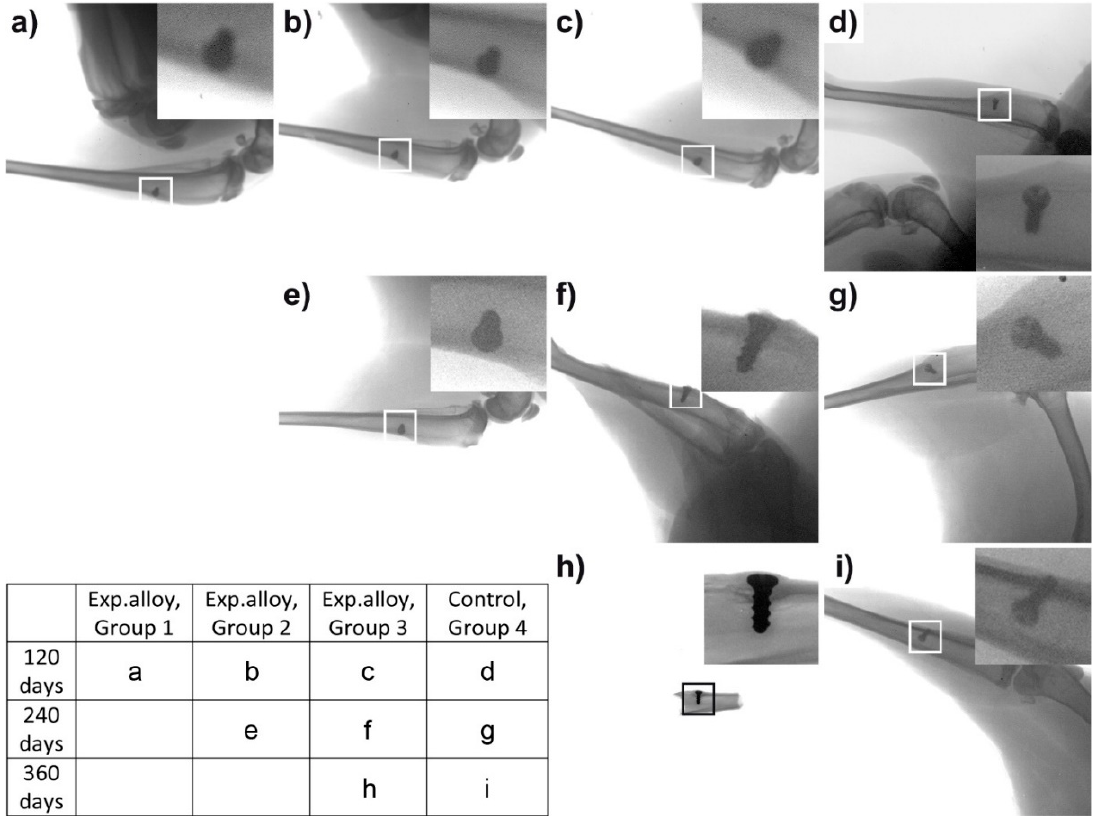
Figure 1. X ‐ ray images (plain radiography) of the tibia bones of experimental rabbits. ( a – d ) 120 days after implantation, ( a – c ) experimental Zn ‐ based screw, ( d ) control Ti ‐ based screw; ( e – g ) 240 days after implantation; ( e , f ) experimental Zn ‐ based screw; ( g ) control Ti ‐ based screw; ( h ) 360 days after experimental Zn ‐ based screw implantation; ( i ) 360 days after control Ti ‐ based screw implantation. There were no osteolytic changes seen on the boundaries between the bone and experimental and Ti ‐ based screws. No detectable differences between groups after 120, 240, and 360 days of implantation. No detectable changes between experimental screw groups and Ti ‐ based screws used as a control.